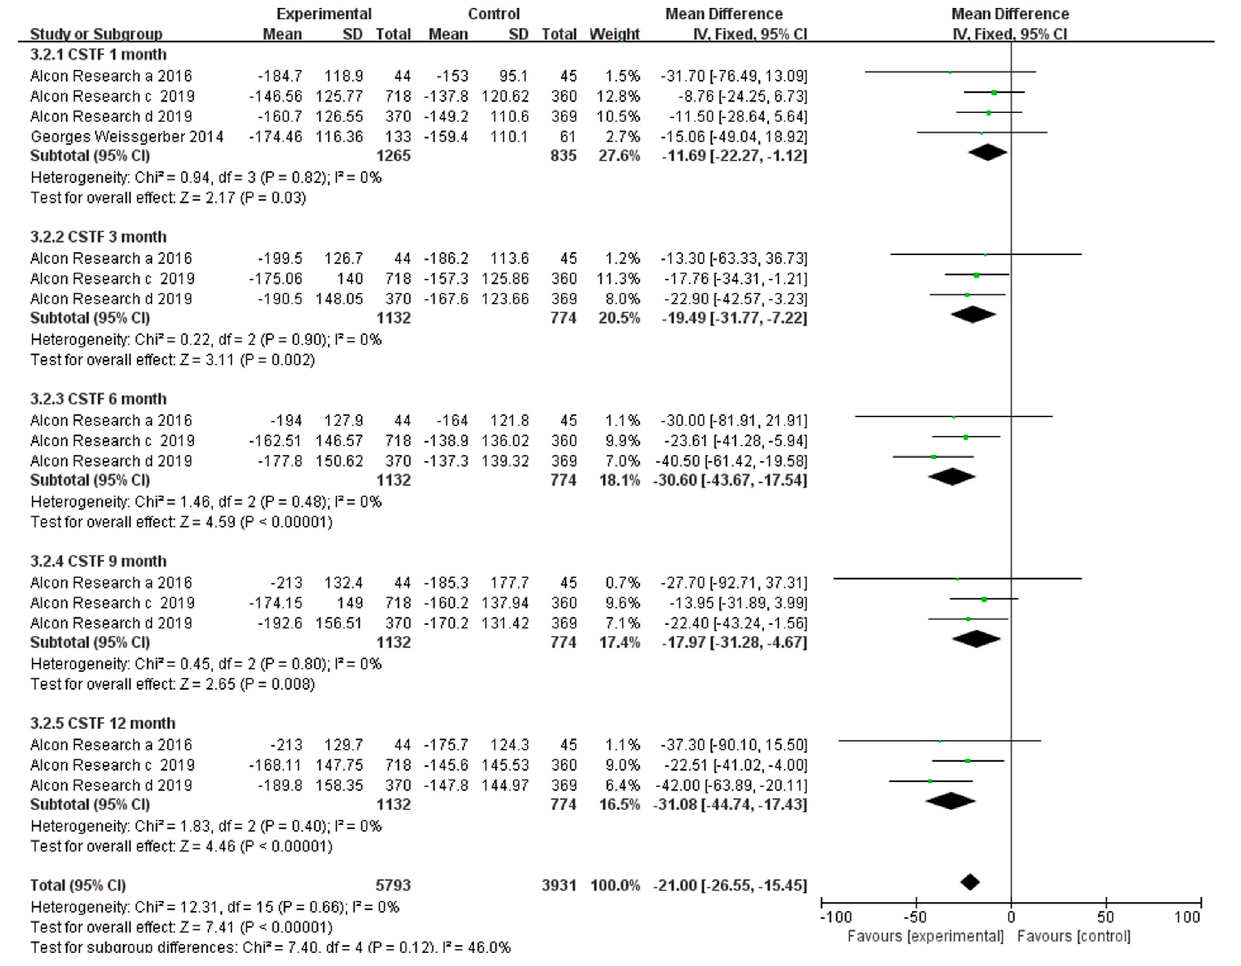
Frontiers in Pharmacology |